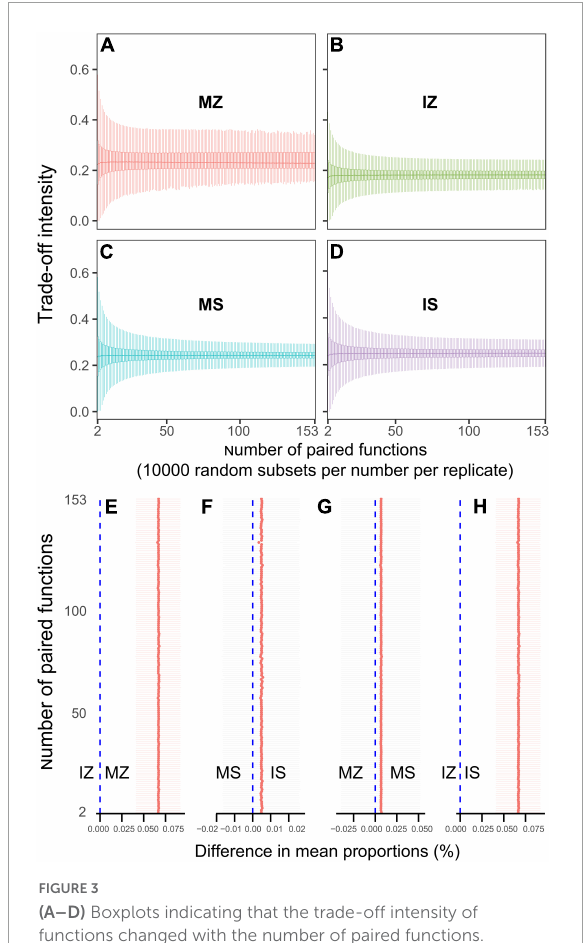
FIGURE3 (A–D) Boxplots indicating that the trade-off intensity of functions changed with the number of paired functions. (E–H) Difference of the trade-off intensity between groups at the number of paired functions (Wilcoxon test at α = 0.05). MZ, monoculture Zea mays ; IZ, intercropping Zea mays ; MS, monoculture Sophora davidii ; IZ, intercropping Sophora davidii .